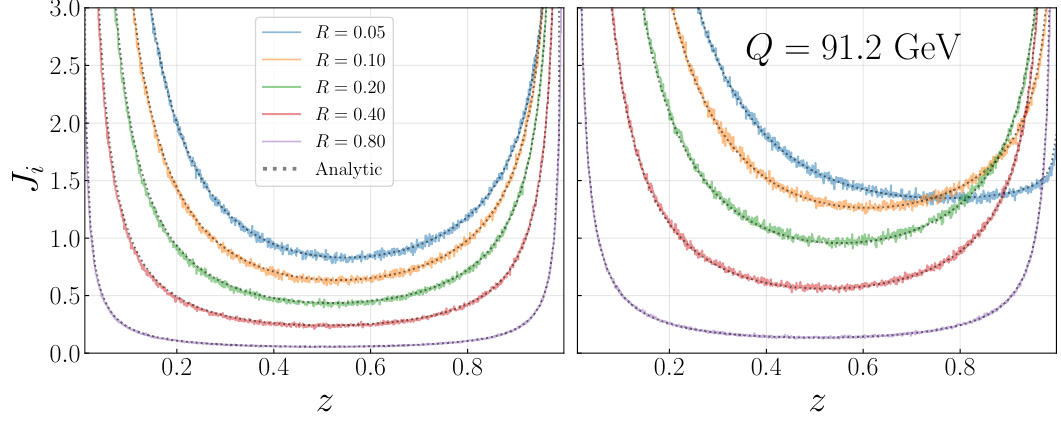
Figure 3 . LO/LL inclusive jet functions for quarks (left panel) and gluons (right panel). We show the results obtained analytically in Mellin space where the contour integral of the inverse transformation is performed numerically and the result from the parton shower. As an example, we choose Q = 100 GeV and five exemplary values of the jet